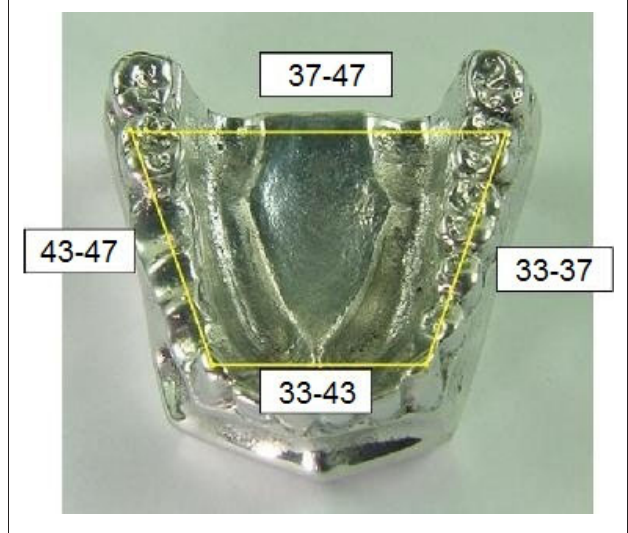
Fig. 1. Distances considered in the